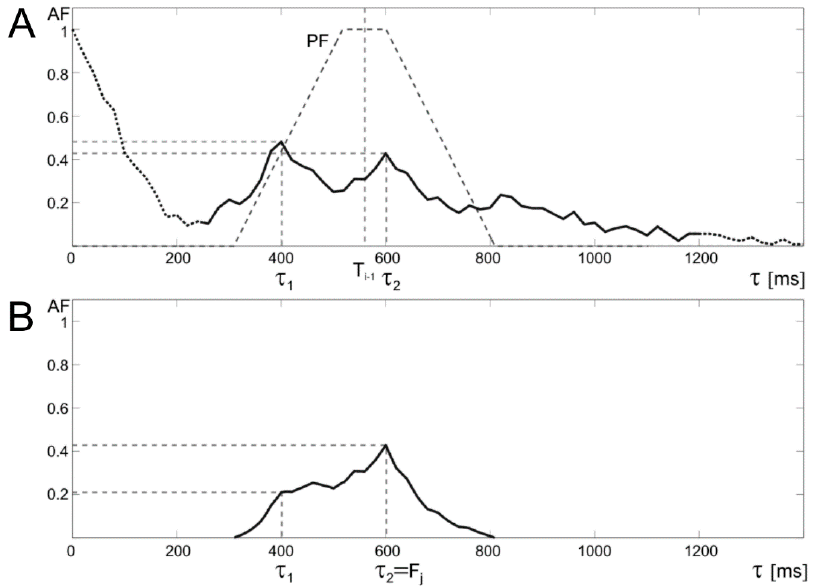
Figure 5. Idea of a trapezoidal window applied for the prediction function (PF). The upper graph ( A ) shows the autocorrelation function with PF, whose center is determined by the last correctly determined value of the T i − 1 interval. The lower graph ( B ) shows that correction of autocorrelation function (AF) by trapezoidal PF which enables determination of the correct periodicity value ( τ 2) and thus the instantaneous measurement F j , despite the distortions in the US signal, which gives false AF maximum ( τ 1) before PF application.